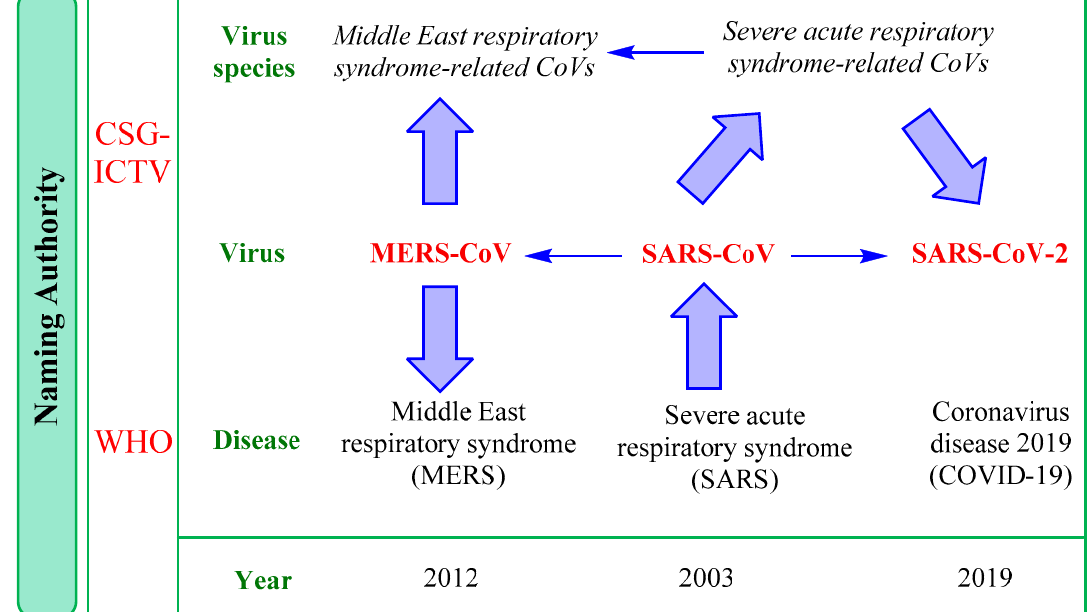
Figure3. Namingofvirusanditsdiscovery; basedontheillnessescurrentinternationalclassification[24]. Figure 3. Naming of virus and its discovery; based on the illnesses current international classification Redrawn from Ref. [25], An Open Access article (CC BY [24]. Redrawn from Ref. [25], An Open Access article (CC BY 4.0).